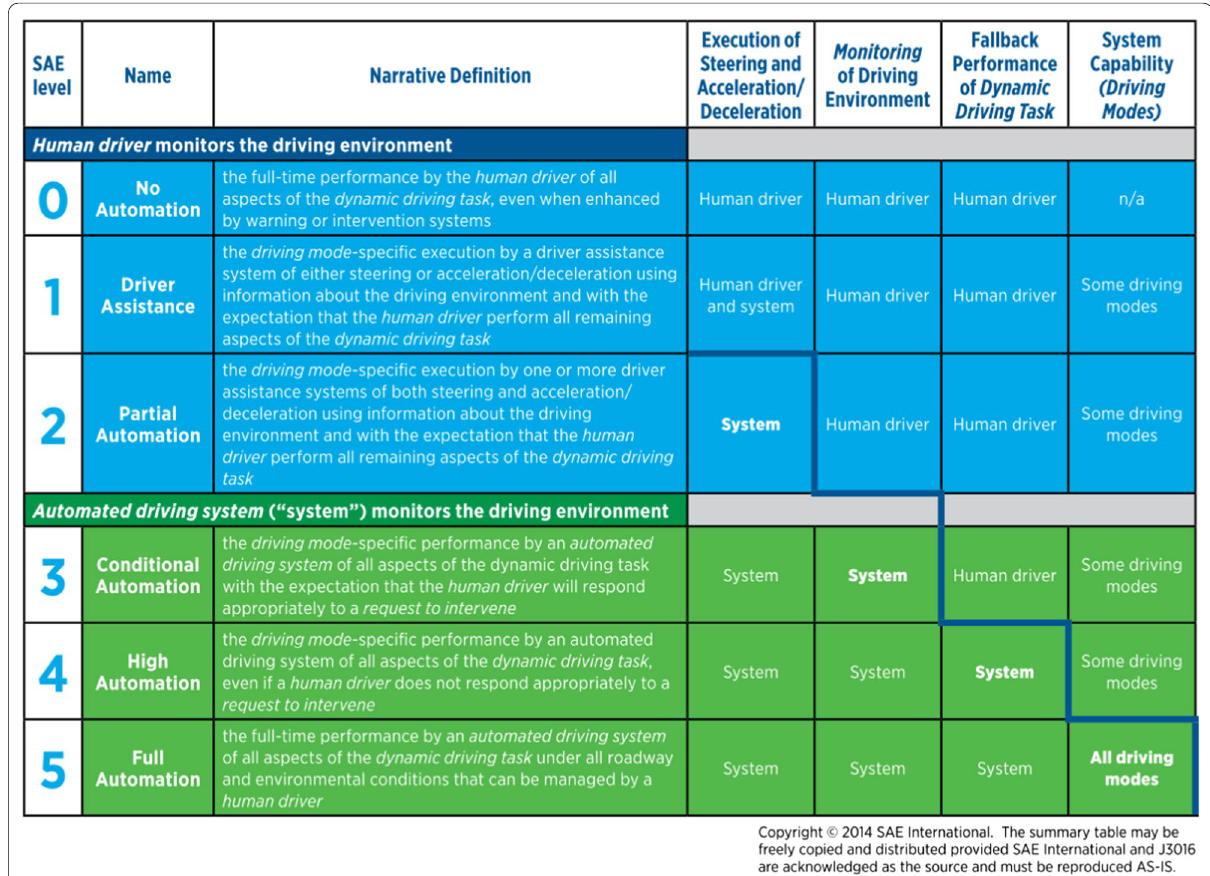
Fig. 6 SAE International’s (2014) summary of the responsibilities of human driver and system at each level of automation for the execution of steering and acceleration/deceleration, monitoring of the driving environment and fallback performance of the dynamic driving